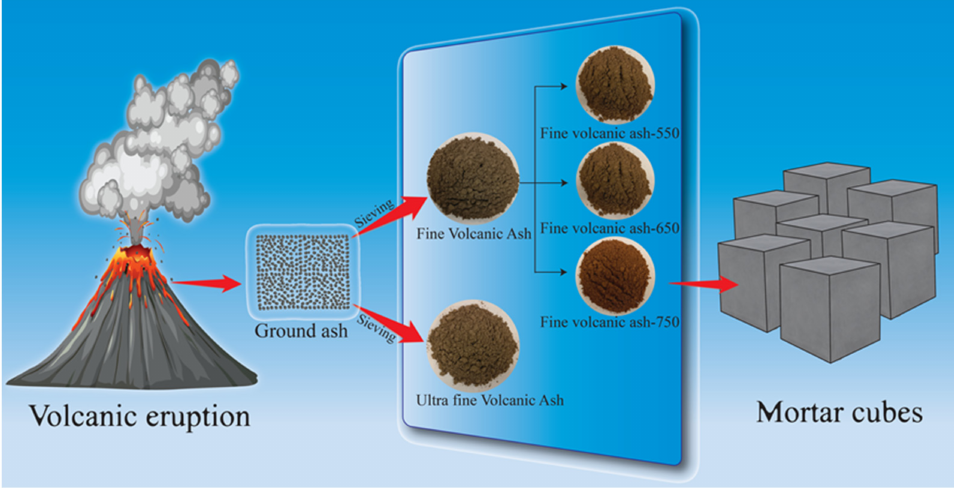
Figure 1. Schematic presentation of the use of volcanic ash for mortar cubes